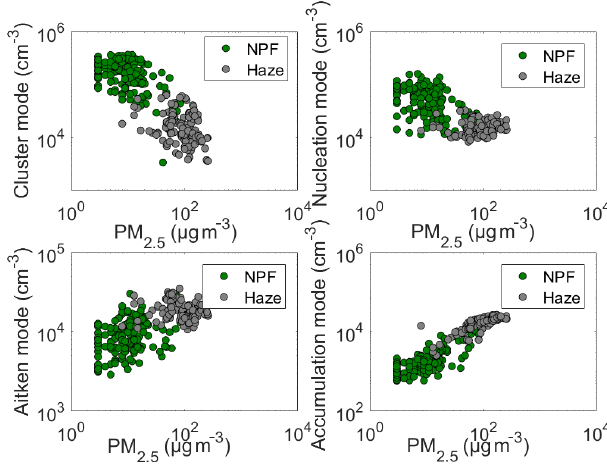
Figure 11. Correlation between PM 2 . 5 concentration and particle number concentration in each mode on the NPF event days (green dots) and the haze days (gray dots) separately. The time resolution of the data points was 1h. Table 2. (a) Correlation coefficients between particle number con- centration of every mode on NPF event days. (b) Correlation co- efficients between particle number concentration of every mode on haze days. The time window was 08:00–14:00LT. High correlation coefficients ( | R | > 0 . 5) are marked with bold and